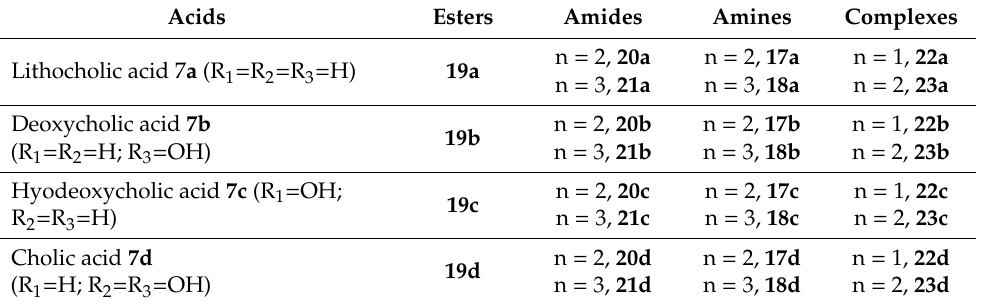
Table 1. Starting bile acids, their synthesized derivatives and target platinum(II) complexes. Acids Esters Amides Amines Complexes Lithocholic acid 7 a (R 1 = R 2 = R 3 =